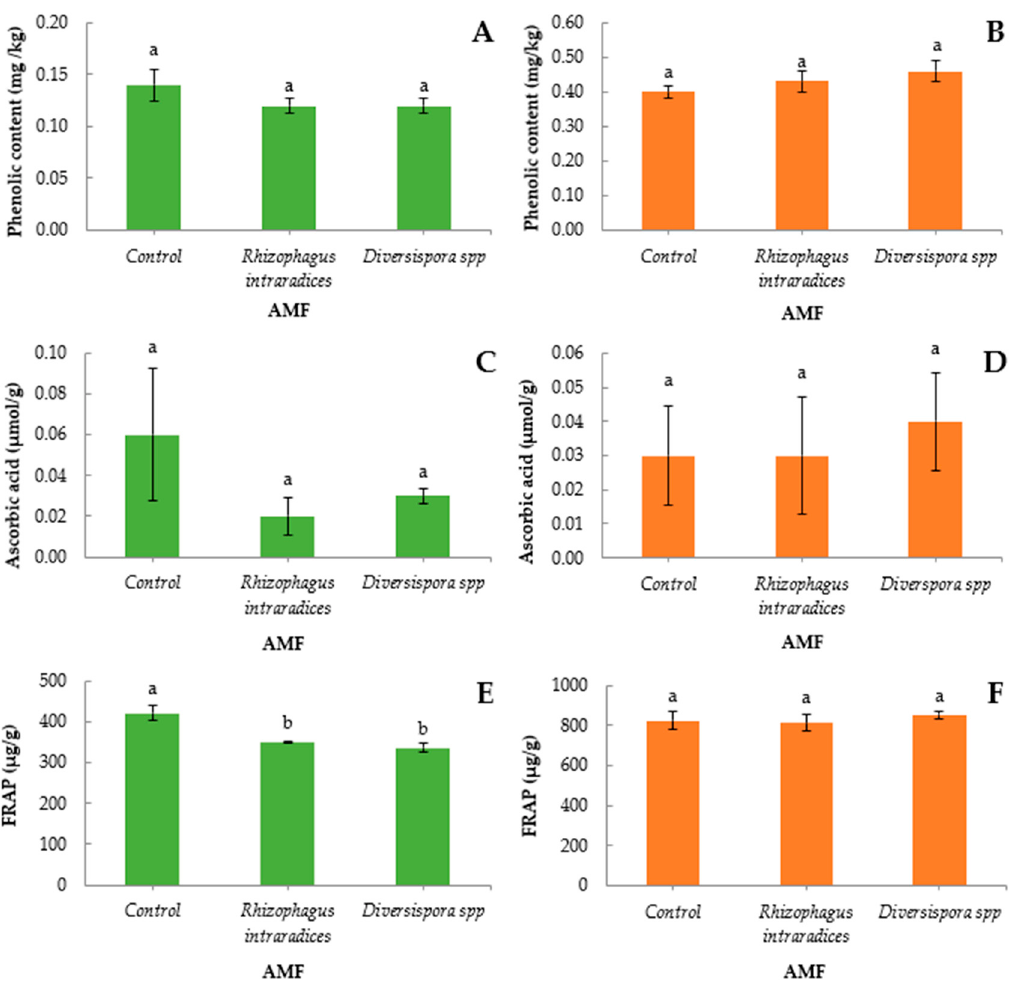
Figure 2. Phenolic content, ascorbic acid content, and antioxidant capacity (FRAP) of lettuce ( A , C , E ) and green onion ( B , D , F ) after application of two arbuscular mycorrhizal inocula ( R. intraradices or Diversispora spp.) or without (control). Bars (average values ± SE) followed by different letters indicate significant differences ( p < 0.05).